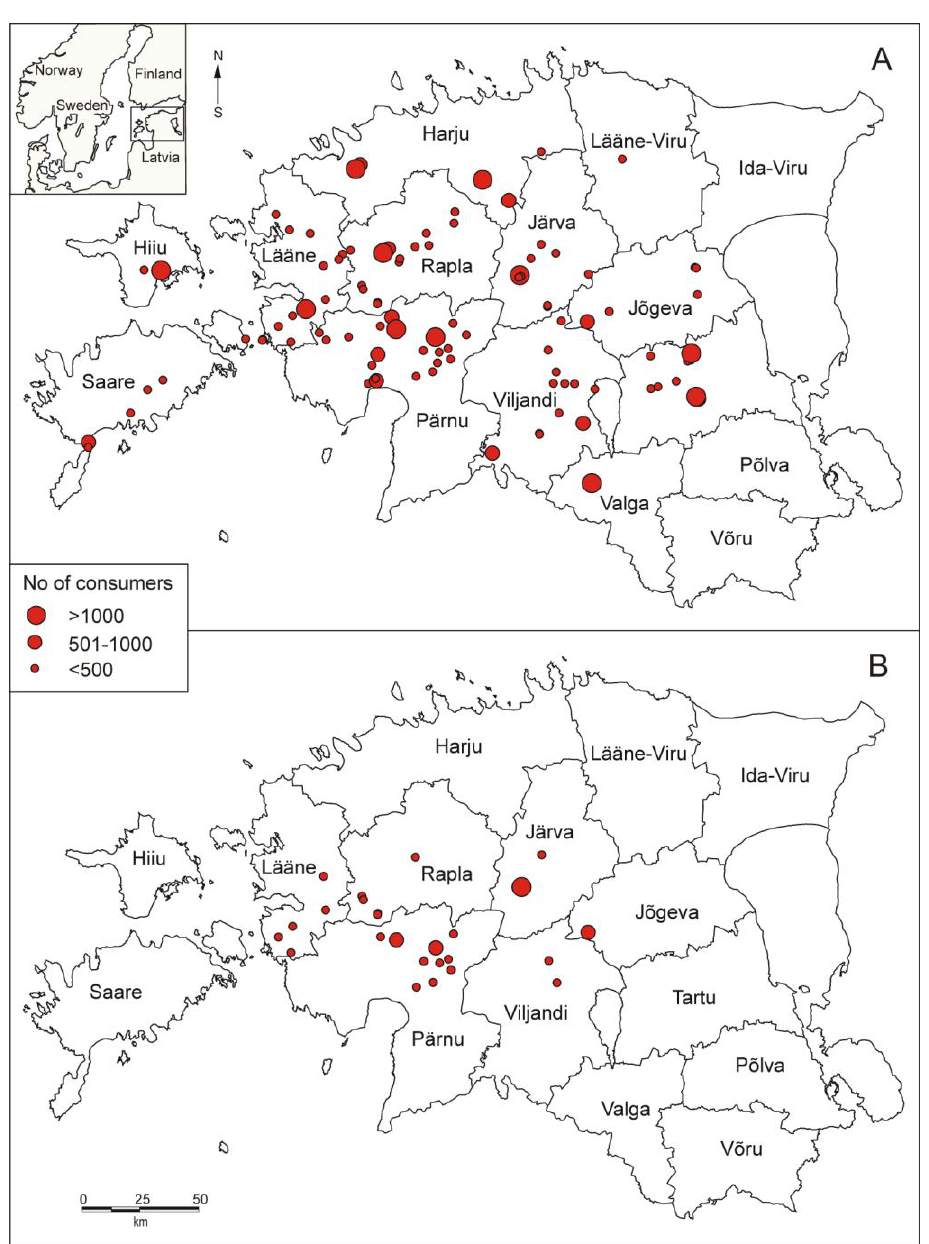
Figure 1. Map of the study area and location of public water supplies with high (>1.5 mg/L) fluoride content by the size of PWS in 2004 ( A ) and 2012 ( B ).